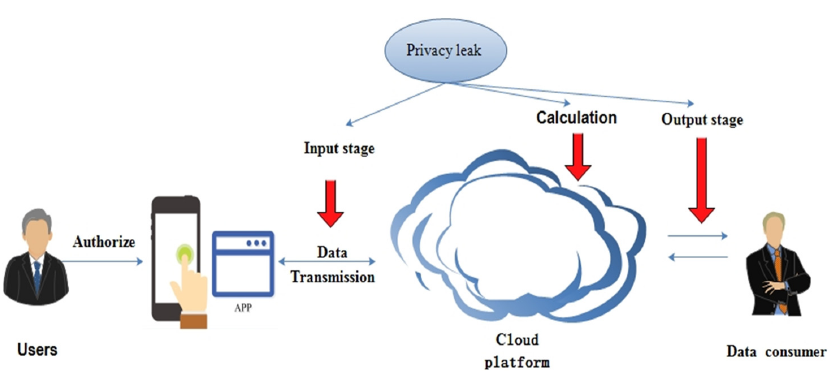
Figure 2. The cloud platform ‐ based big data computing environment.